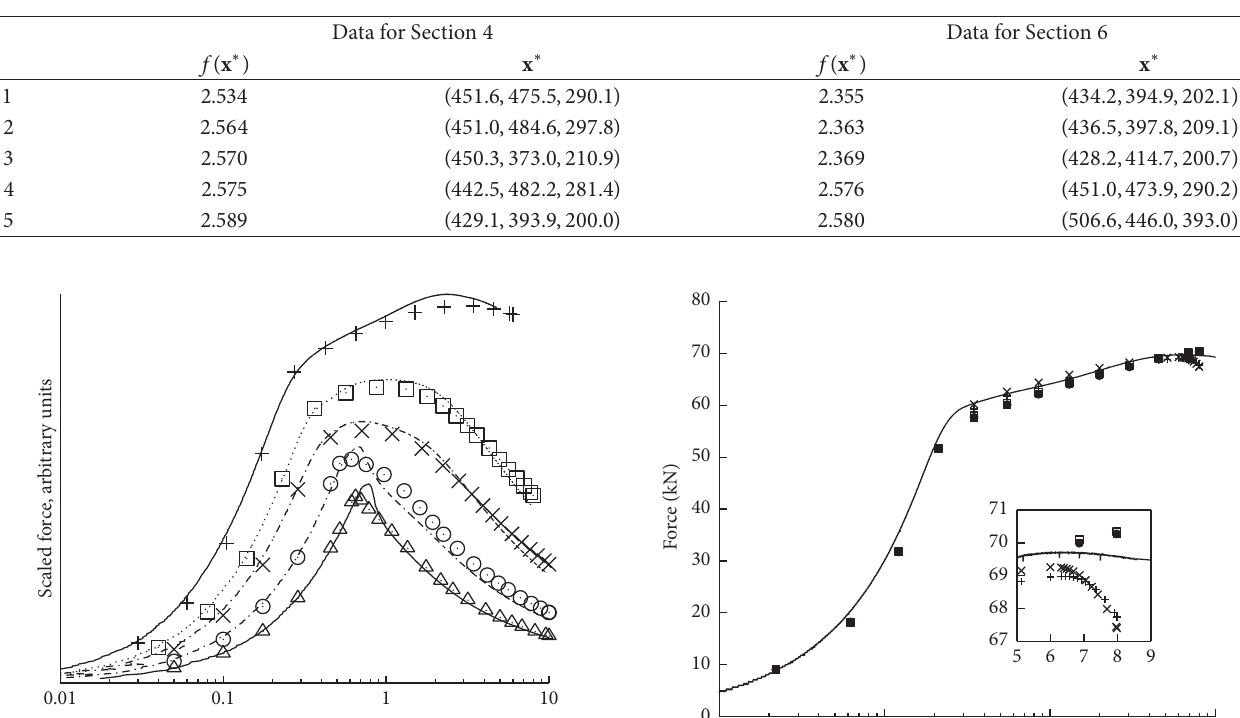
Table 3: Five lowest minima for multistart global optimisation. Columns 2 and 3 show the minima from using only buckling experimental data, Section 4. Columns 4 and 5 show the minima from using buckling and tensile experimental data, Section 6.